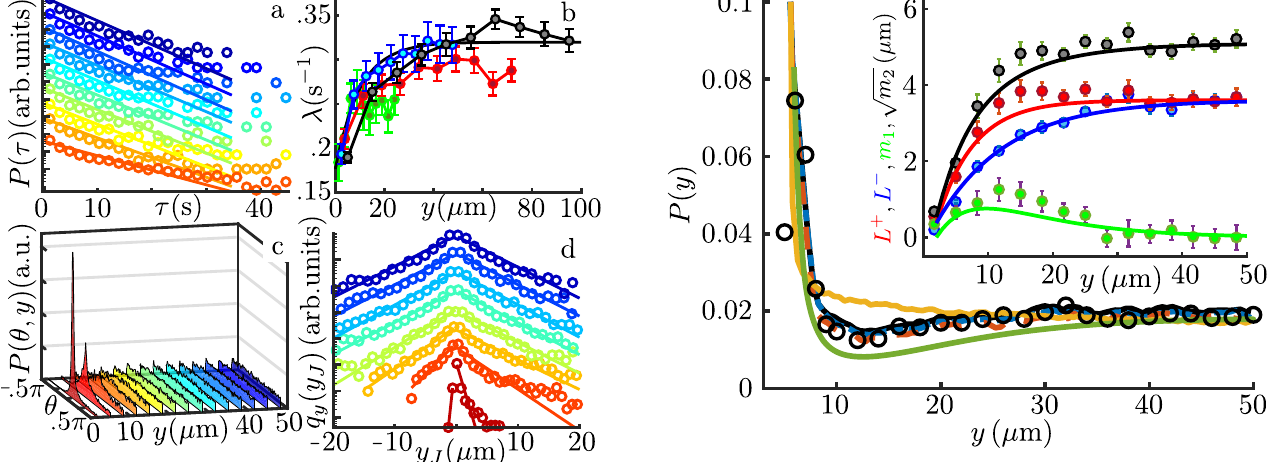
Fig. 2 | Colloidal jump dynamics. a Probability distribution function of waiting times between consecutive jumps ( W =50 μ m, semilog plot) Circles: experiments. Solid lines: exponential fi ts. The distributions are shifted vertically for clarity. Col- ours code for position across the channel (red: boundary; blue: channel centre). b Characteristic encounter rates λ ( y ) for the four values of W , as a function of distancefromthechannelboundaries.Forbettercomparison,thevalueshavebeen rescaledto the cellconcentration of the 100 μ m-wide channel (see Supplementary Section 3). Circles: experiments. Solid Lines: exponential fi ts (see Methods). Error bars from the fi t uncertainties. c Probability distribution function P ( θ , y ) for the direction θ of active jumps vs. distance y from the channel boundary ( W =50 μ m). d Semilogplotofactivejumpdistributions, q y ( y J ),fordifferentdistances y fromthe boundary (Colours as in C). Circles: experiments. Solid lines: exponential fi ts. The distributions are shifted vertically for